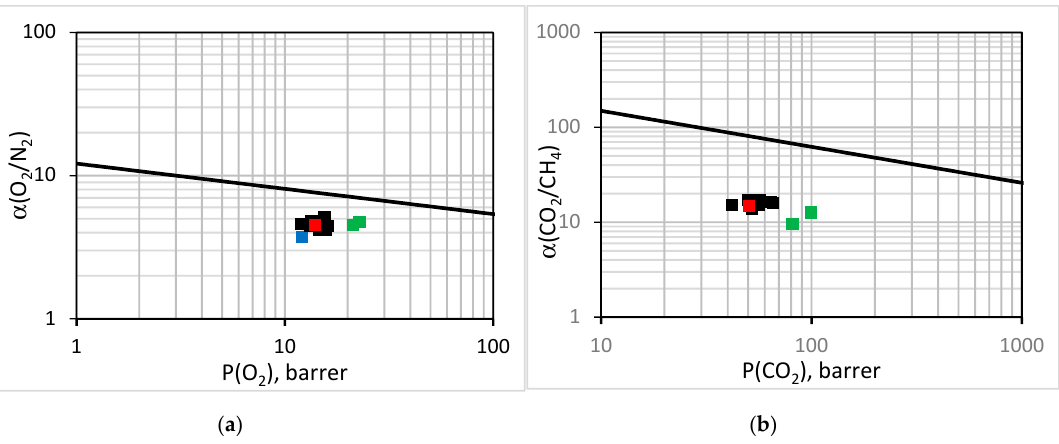
Figure 8. Performance of the synthesized EPMM (green squares) membranes, reference PPO (red square) membranes, and first-generation EPMM membranes [43] (blue square) in comparison to the literature data for PPO [29–34,37,59–62] (black squares) and the upper bound line for ( a ) O 2 /N 2 and ( b ) CO 2 /CH 4 .